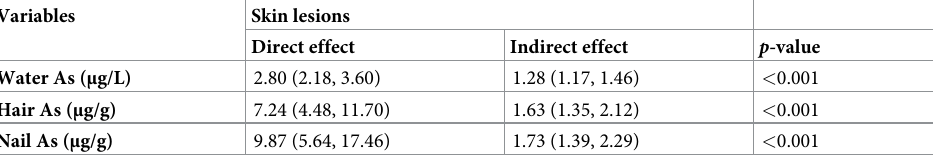
Table 3. Direct and indirect effects of arsenic exposure levels (mediated by periostin levels) on skin lesions.